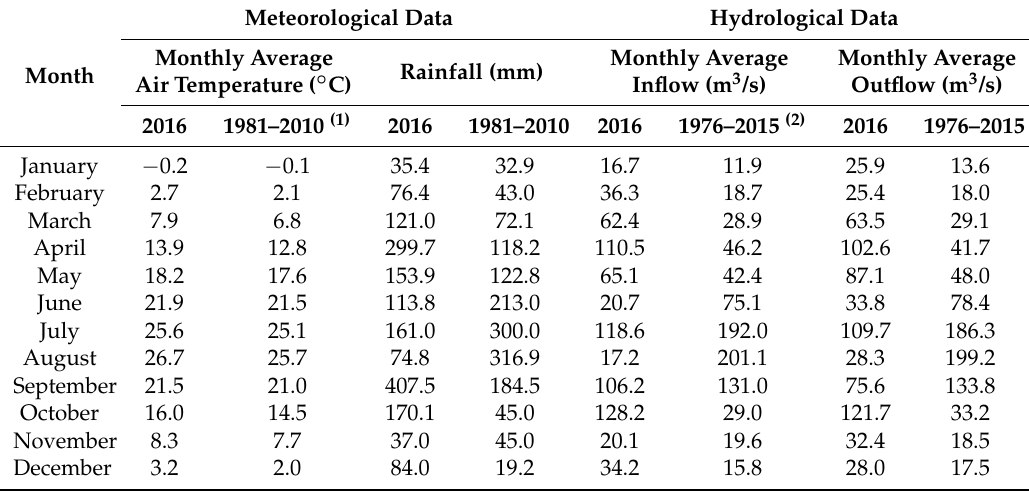
Table 1. Monthly meteorological and hydrological data for the Namgang Dam in 2016 and comparison with past